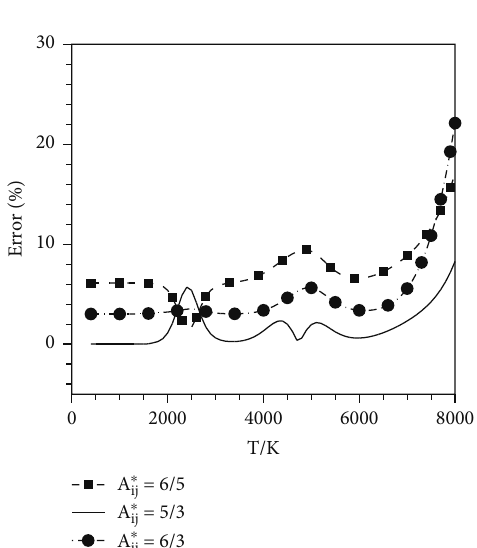
Figure 7: Relative deviation of viscosity between equation (11) at three assumptions of A ∗ ij and the CE method at